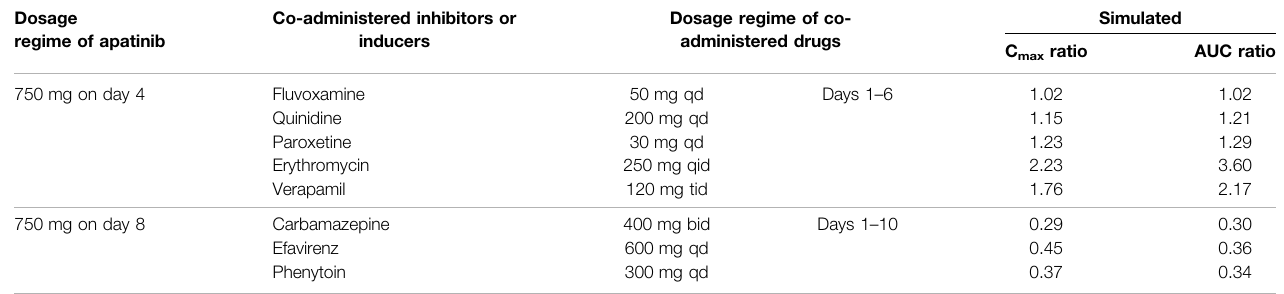
TABLE 5 | Simulated exposure changes of apatinib with co-administration of possible inhibitors or inducers